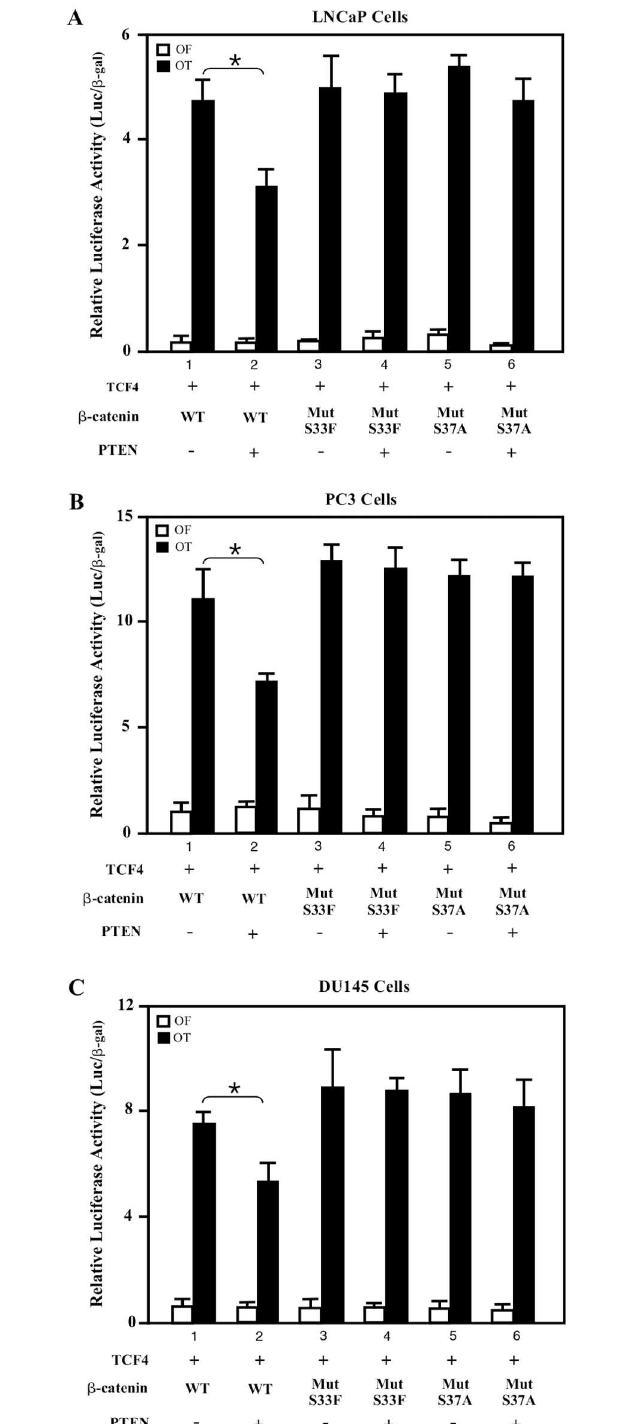
Fig 1. PTEN repressesß-catenin transcriptional activity in multiple prostate cancer cell lines. (A) LNCaP cells were transfected with TOPflash (pGL3-OT) or FOPflash (pGL3-OF) luciferasereporter (100 ng), pcDNA3-ß-gal (25 ng), pcDNA3-Tcf4 (5 ng), and the wild-typeor mutants of pcDNA3-Flag-ß-catenin (50 ng). Either an empty pCMV5 vector or pCMV5-PTEN were co-transfected with the aboveplasmids. Cell lysates were measuredfor luciferase and ß-gal activities. Similar experiments were performed in (B) PC-3 and (C) DU-145cells. The data represent the mean ± S.D. of three independent samples. “ * ” means P < 0.05.